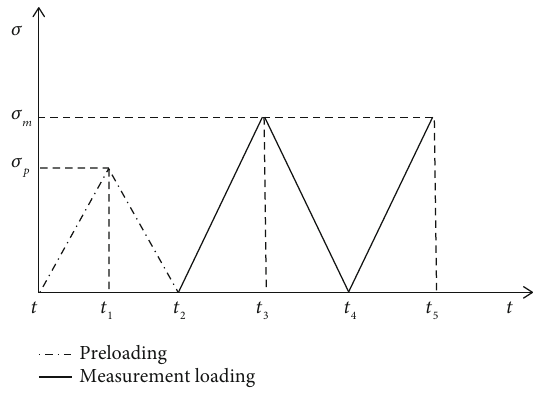
Figure 2: Loading